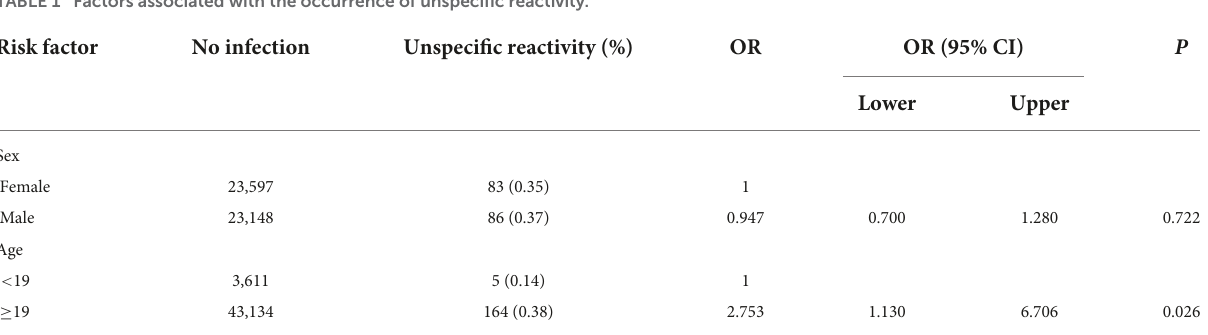
TABLE 1 Factors associated with the occurrence of unspecific reactivity.